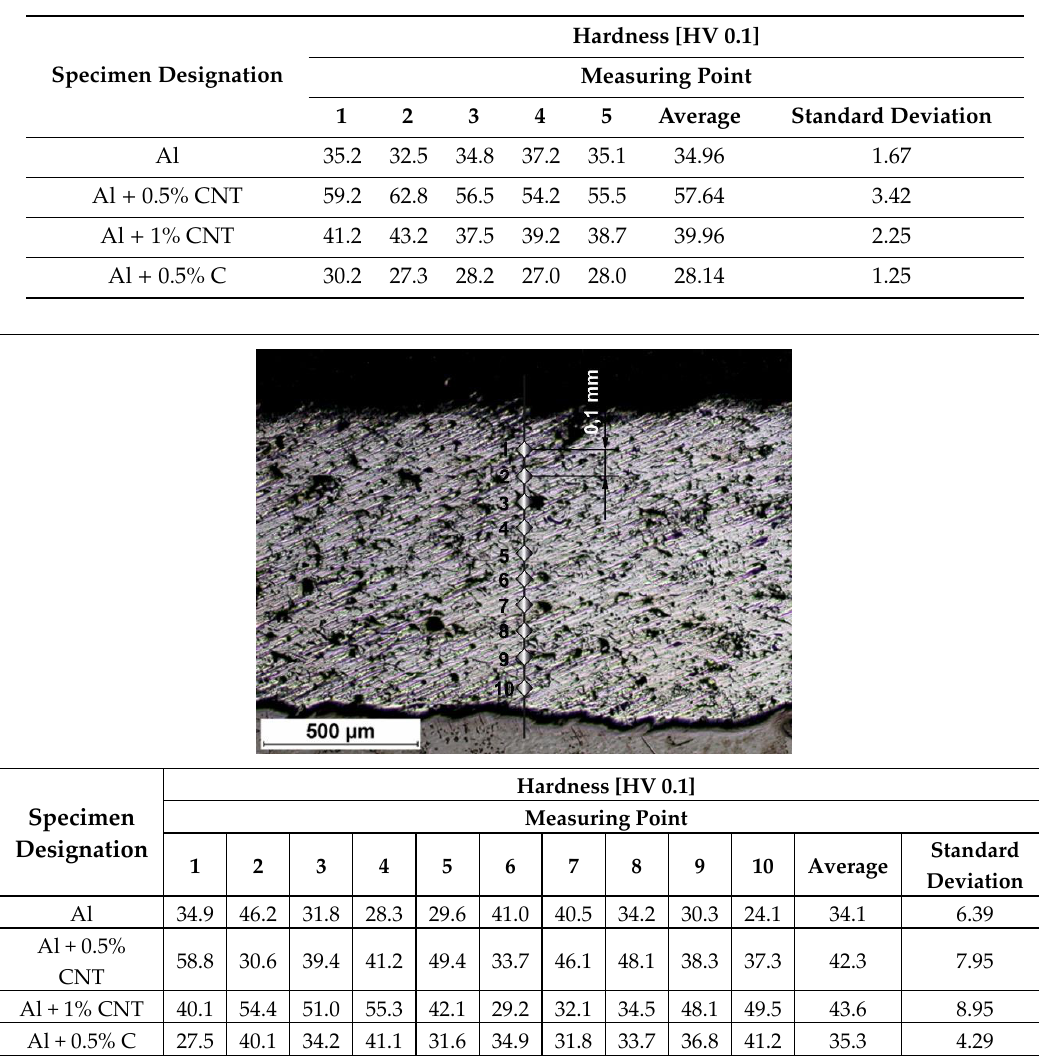
Figure 10. Hardness measurements scheme and HV 0.1 results of the flame-sprayed aluminum and aluminum reinforced with carbon materials coatings .